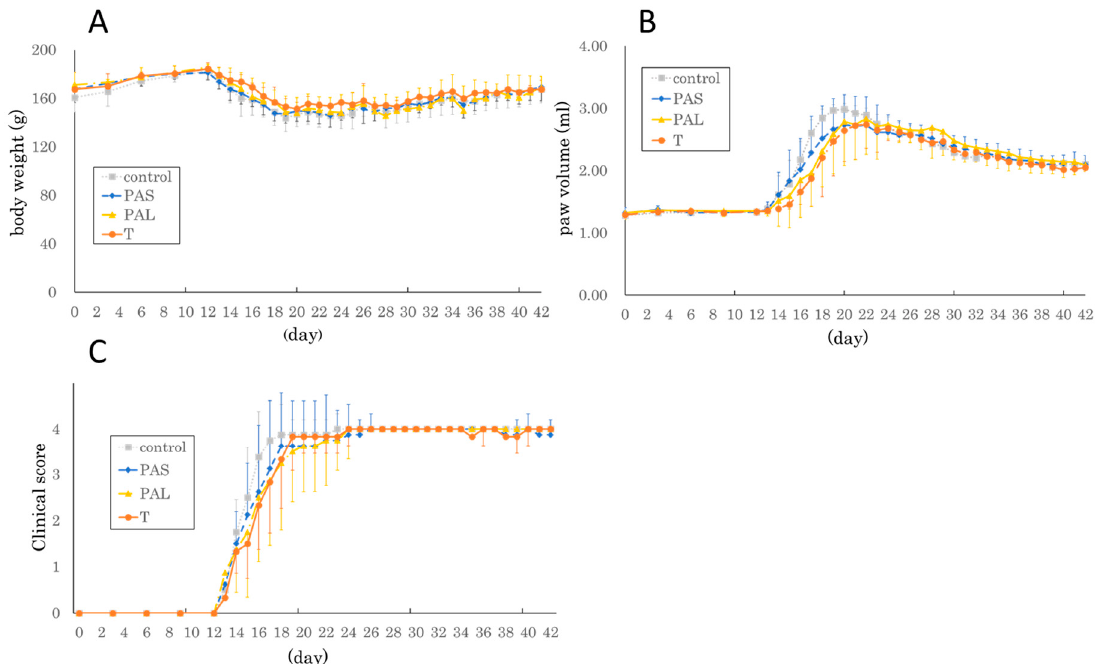
Figure 1. Kinetic change in ( A ) body weight, ( B ) paw volume, and ( C ) clinical score after immunization. The parameters were measured once every three days until day 12 and every day thereafter. There were no significant differences among the four groups (no intervention group, control; pre-arthritis intervention short group, PAS; pre-arthritis intervention long group, PAL; therapeutic intervention group, T) on all days.